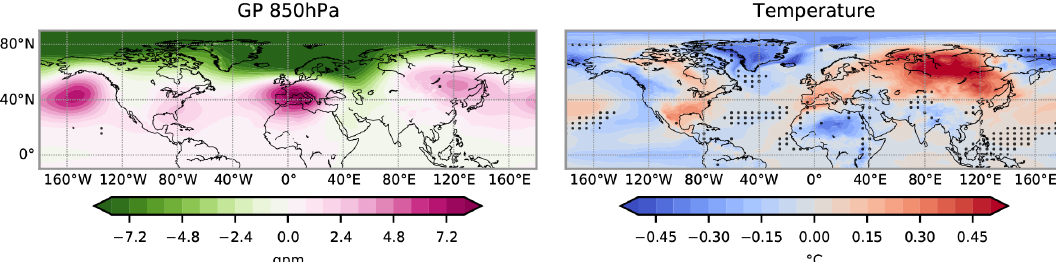
Figure 15. Detrended mean geopotential height anomaly at 850hPa and surface temperature anomaly during Mediterranean droughts for the 1850–2099CE. Black dots indicate the regions where the distributions between the detrended 1850–2099CE and 850–1849CE are statistically different at the 5% confidence level (Fig. 8) from the Mann–Whitney U